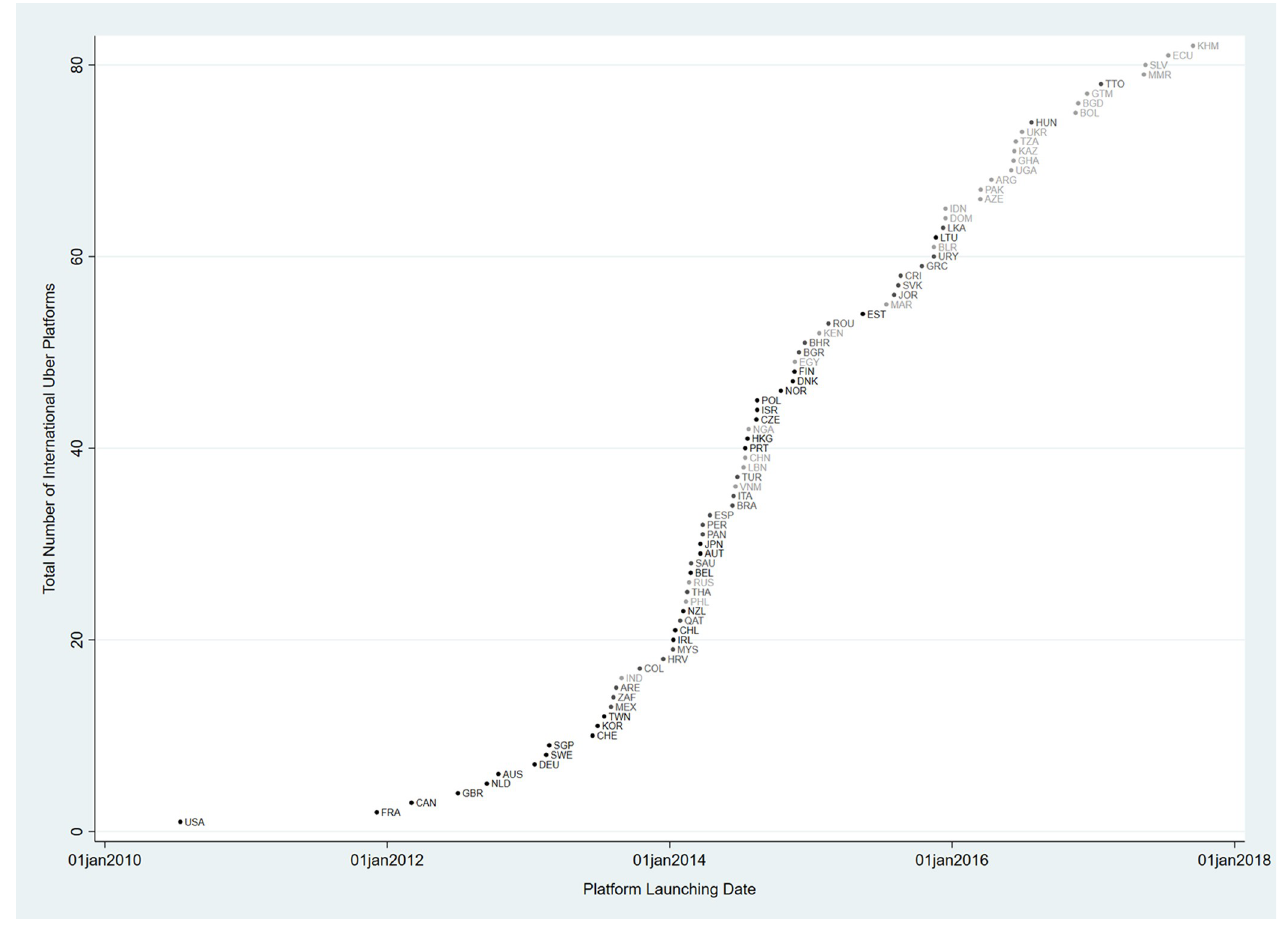
Fig 1. The international diffusion of Uber,